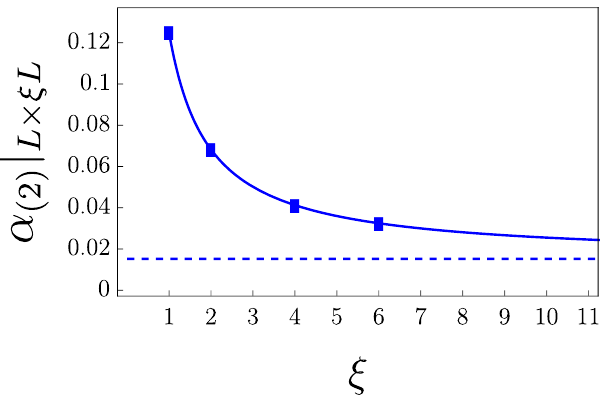
Figure 11 . We plot the values of the leading coefficient in the mutual information of a free scalar field in the long-distance regime for pairs of rectangle regions of dimensions L × ξL , as a function of ξ . The solid curve is the fit presented in the main text, and the dashed line, the asymptotic value corresponding to ξ → ∞ (namely, very thin